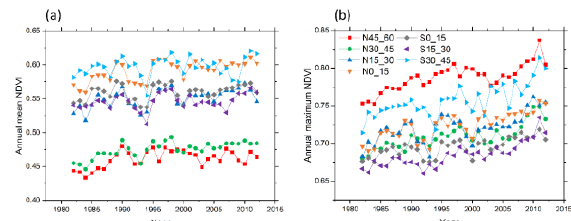
Figure S4. Annual mean NDVI (a) and annual maximum NDVI (b) changes along geographic latitude zones with 15o latitude intervals from 60o N to 45o S over the past three